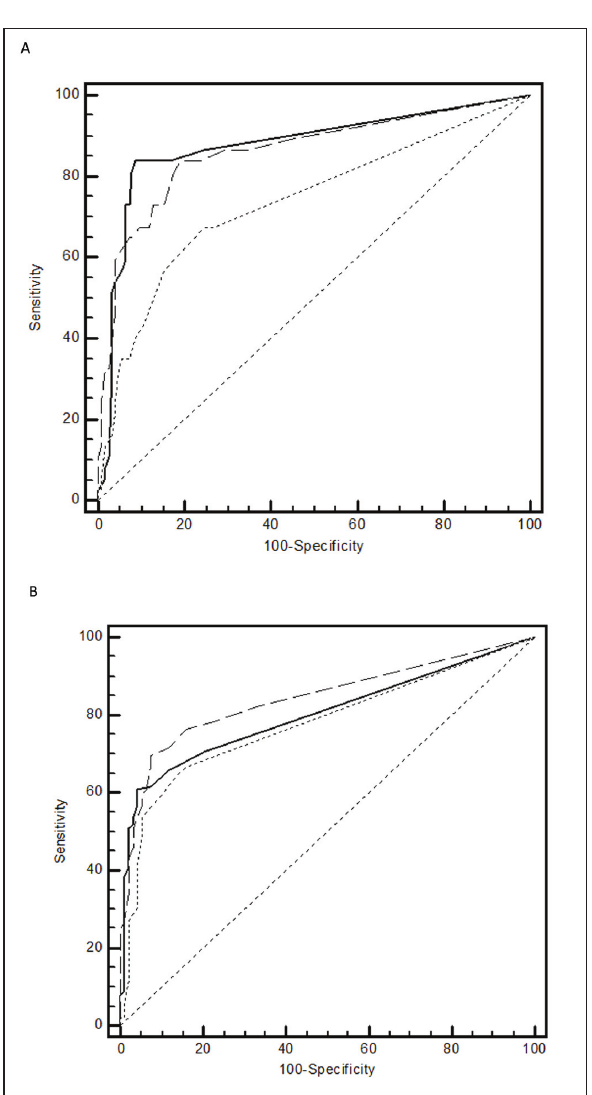
Fig. 3. Comparison of ROC curves for o-IgG (solid line), o-free κ (dashed line) and o-free λ (dotted line). (A) For the diagnosis of multiple sclerosis. (B) For the diagnosis of inflammatory nervous system disease. For MS di- agnosis, AUC values were 0.876 (95% CI: 0.816-0.923), 0.862 (95% CI: 0.800-0.911), and 0.739 (95% CI: 0.664-0.804); for IND diagnosis, AUC values were 0.802 (95% CI: 0.739-0.855), 0.843 (95% CI: 0.784-0.891) and 0.777 (95% CI: 0.712-0.833), for o-IgG, o-free κ and o-free λ respectively ( P <0.0001 in all cases). Differences between areas were significant for o-IgG ver- sus o-free λ ( P =0.0008) and o-free κ versus o-free λ ( P =0.0026) in A, and between o-free κ versus o-free λ ( P =0.0059) in